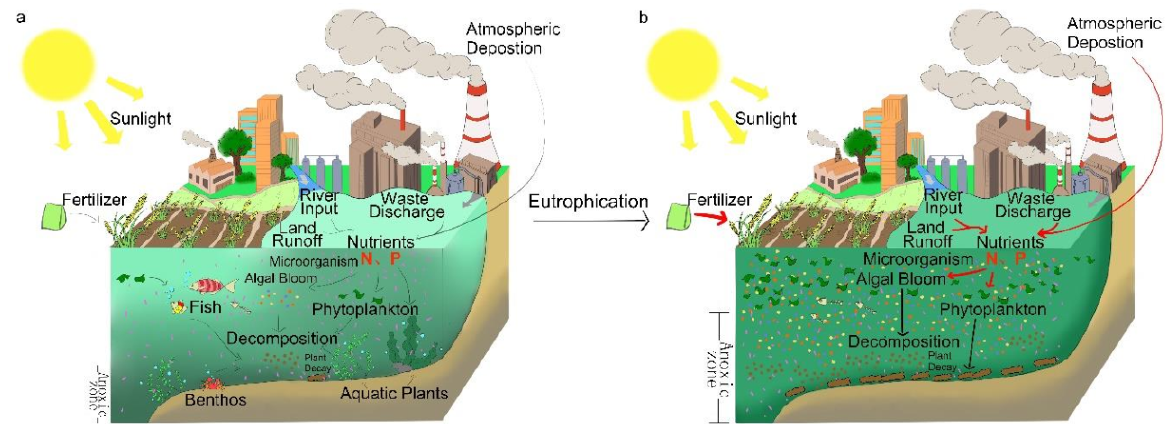
Figure 1. ( a ) Sources of nutrient inputs and the cycling of nutrients in the water body, ( b ) Demonstration of eutrophication and its effects in the water